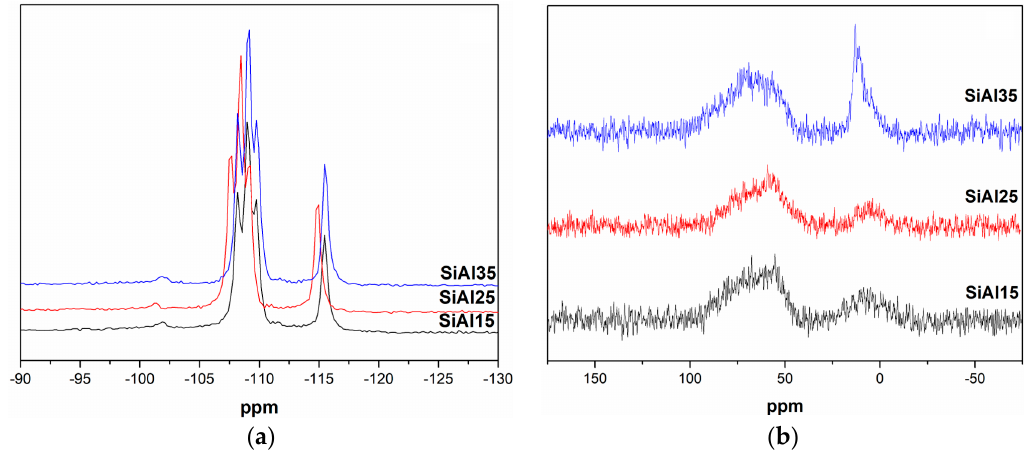
Figure 4. 29 Si ( a ) and 27 Al ( b ) MAS NMR (Magic-angle spinning solid-state nuclear magnetic spectroscopy) spectra of the calcined samples. Table 3. 29 Si MAS NMR (Magic-angle spinning solid-state nuclear magnetic spectroscopy) chemical shifts of the calcined samples SiAl15, SiAl25, and SiAl35.